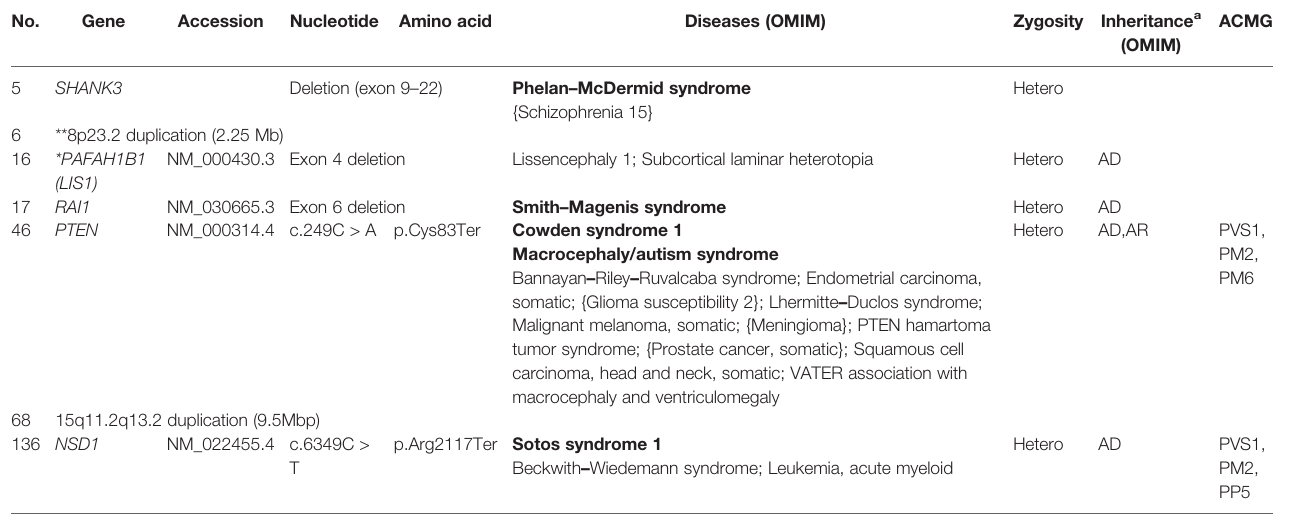
TABLE 3 | Genetic characteristics: genes with pathogenic variants.